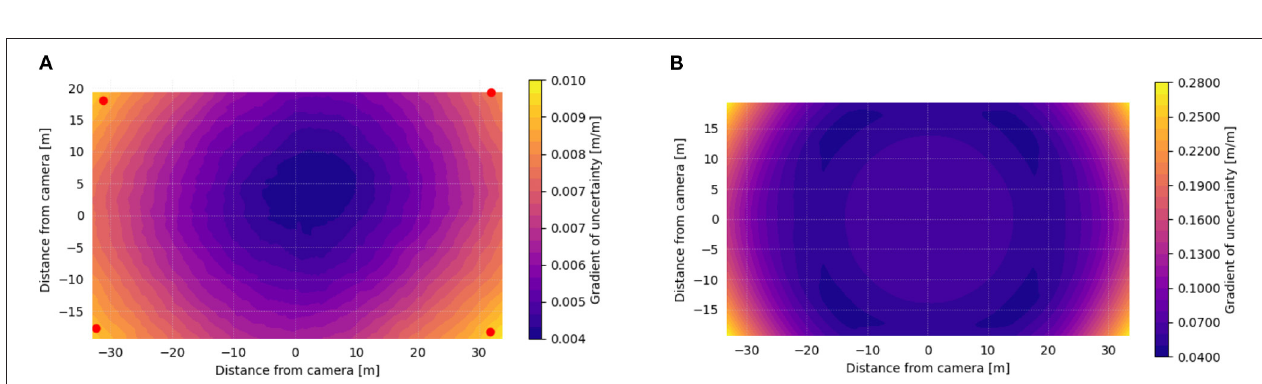
FIGURE 7 | Contours of the 95th percentile of the gradient of spatial uncertainty estimated at each pixel footprint in a normal view (UAV) camera. (A) Using 4 GCPs located near the corners of the FOV (red dots), and correcting for radial distortion. (B) Using direct georeferencing, without correcting for radial distoriton.